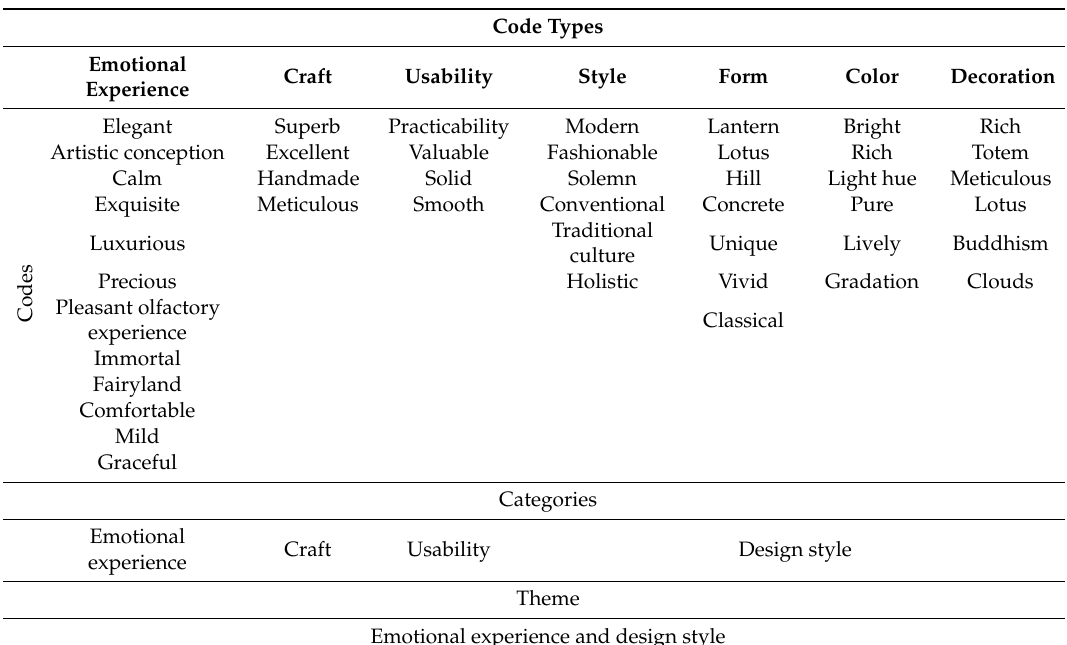
Table 4. The Codes, Categories, and Themes Associated with Pleasant Features of the Hill